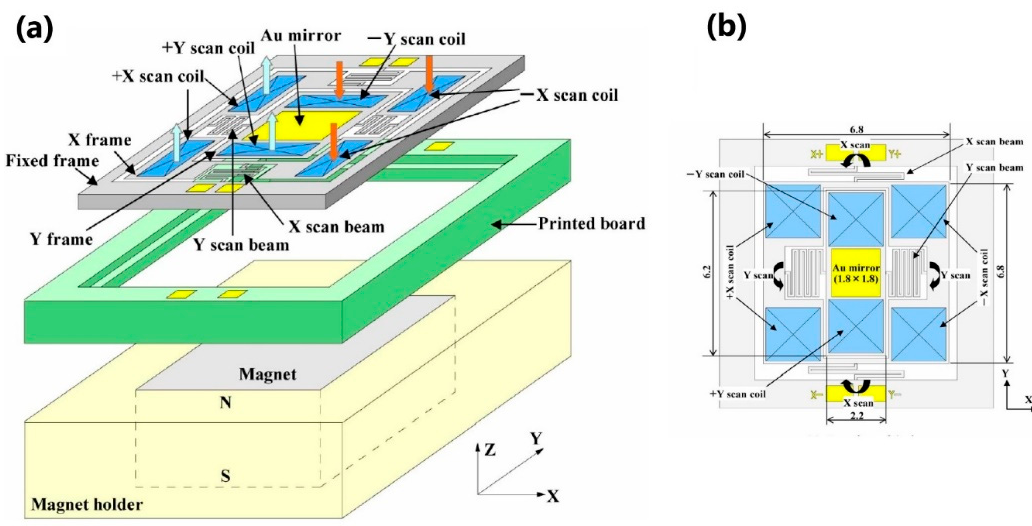
Figure 17. Architecture of the MEMS electromagnetic scanner: ( a ) device schema and ( b ) the top view of the mirror actuator (Figures from [56]).